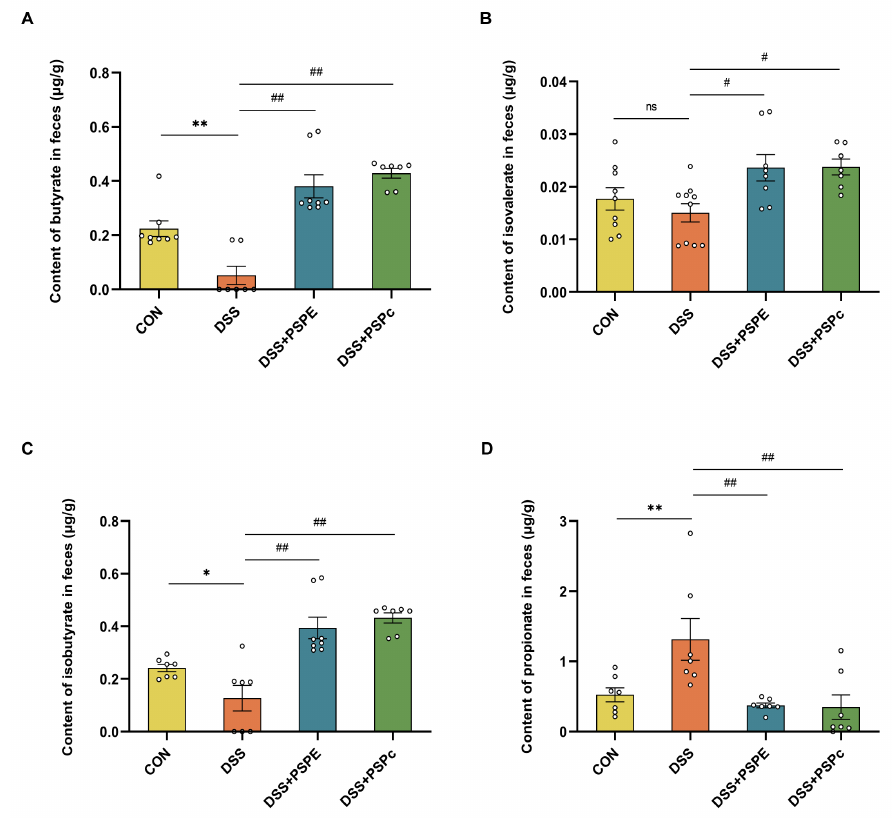
Figure 6. Effect of PSPE and PSPc on the SCFA generation in DSS-induced colitis mice. ( A ) Content of butyrate in feces; ( B ) content of isobutyrate in feces; ( C ) content of isovalerate in feces; ( D ) content of propionate in feces; data were expressed as mean ± SE ( n = 7–10 mice). * p < 0.05, ** p < 0.01, compared with the Con group, # p < 0.05, ## p < 0.01, compared with the DSS group, ns = not signif- icant.